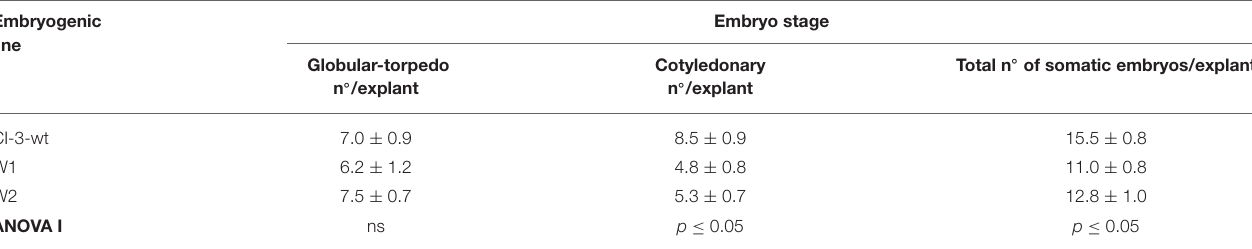
TABLE 1 | Secondary embryogenesis ability of non-transgenic line (CI-3-wt) and two mutated lines (W1 and W2). Embryogenic